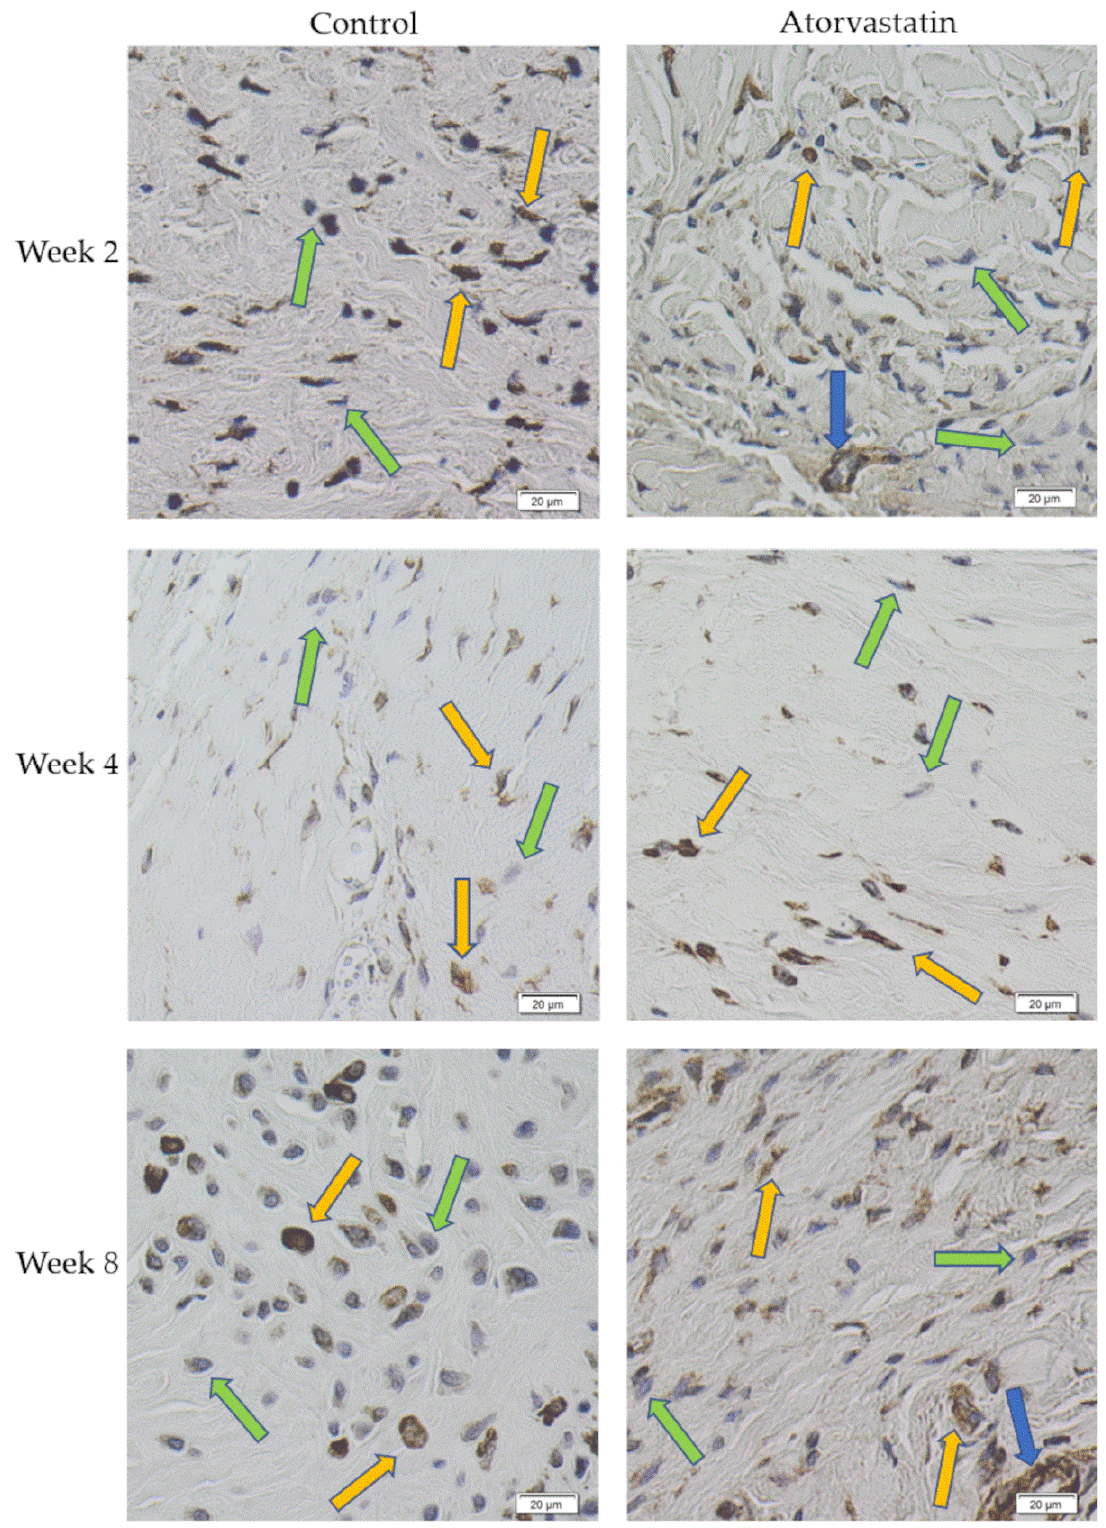
Figure 6. α -SMA-positive staining of myofibroblasts (yellow arrows) and vascular endothelial cells (blue arrows); α -SMA-negative staining of fibroblasts (green arrows).